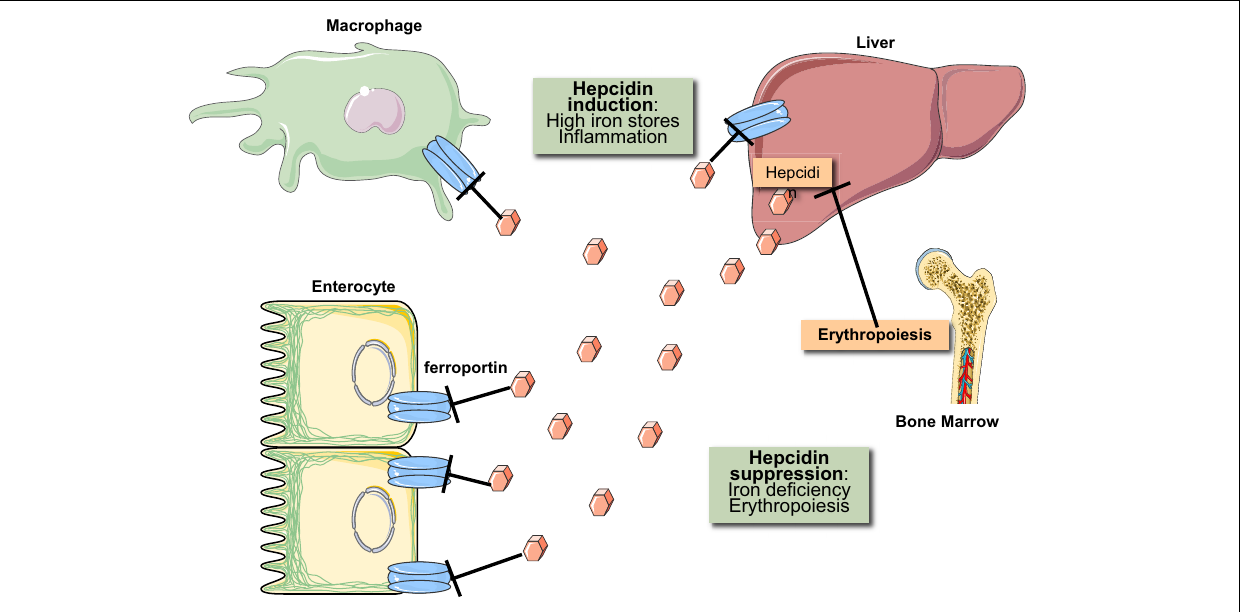
FIGURE 2 | Hormonal regulation of iron efflux from reticuloendothelial macrophages and duodenal enterocytes. The iron regulatory hormone hepcidin is secreted by liver hepatocytes and targets the iron transporter ferroportin on the plasma membrane of iron-exporting cells. The binding of